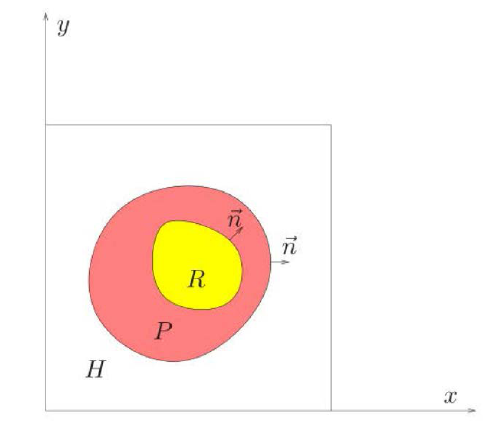
Figure 2. Unit cell containing a single rod cross section. R represents the rod cross section , P the plasmonic coating and H the